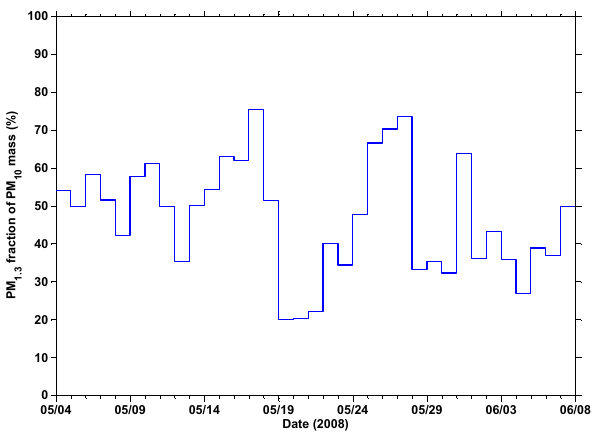
Fig. 8. Mass fraction of PM 1 . 3 over PM 10 mass as a function of time.